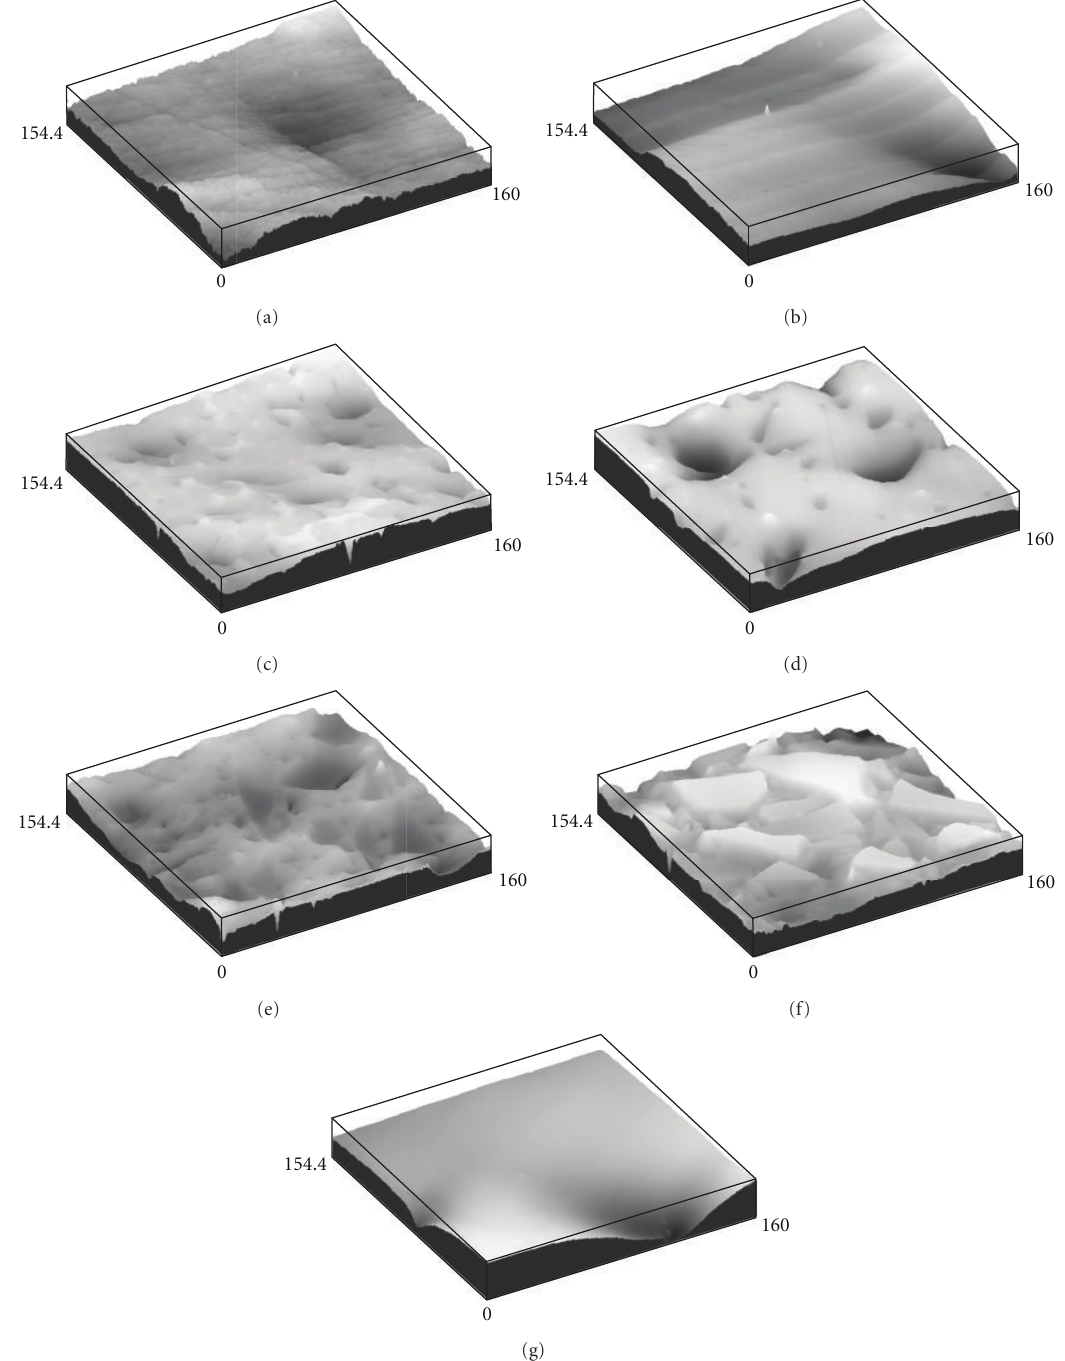
Figure 3: Confocal profiler 3D images of specimens investigated: (a) 100% polymer; (b) polymer with in-plane oriented fibers; (c) polymer with transversely oriented fibers; (d) 75% polymer + 25 wt. % fraction of BAG-particles; (e) 50% polymer + 50wt. % fraction of BAG-par- ticles; (f) 25% polymer + 75 wt. % fraction of BAG-particles; (g) 100%